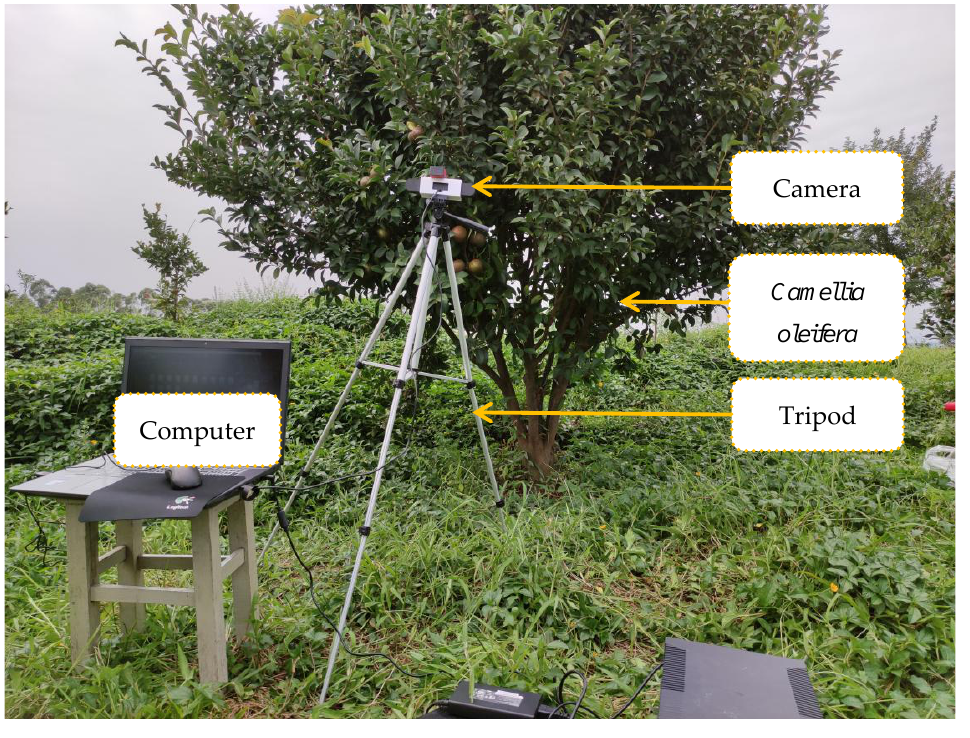
Figure 1. Experimental equipment.